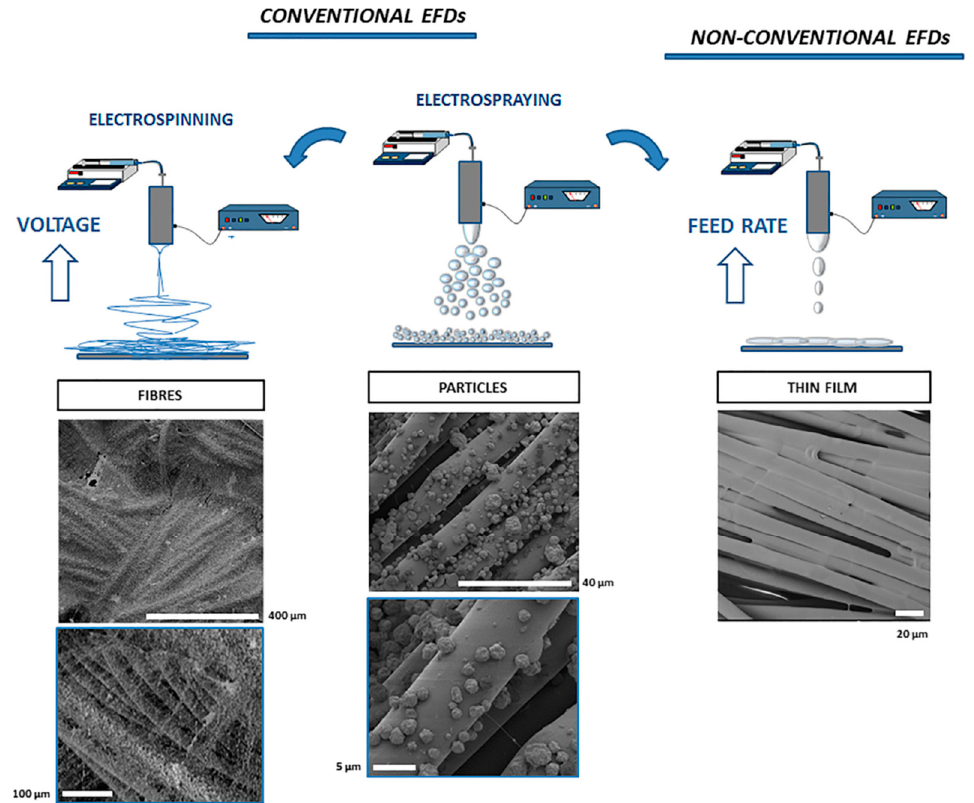
Figure 4. Schematic of the electrofluidodynamic (EFD) process and the corresponding SEM images of the fibers obtained using the EFD process. Reprinted from Journal of Colloid and Interface Science